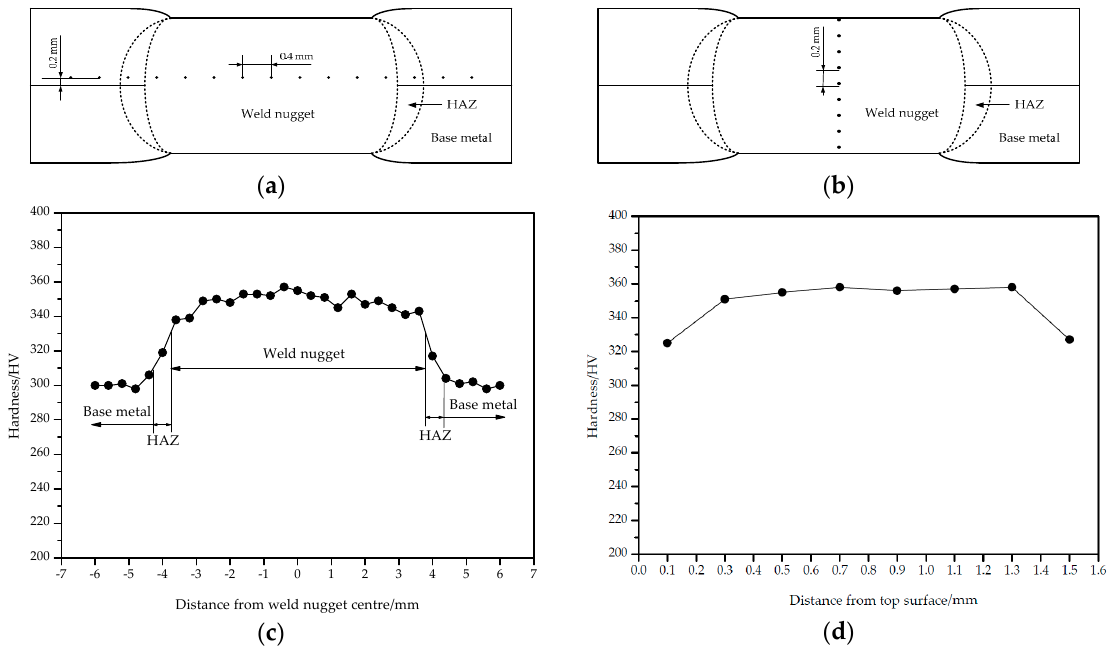
Figure 11. ( a ) Horizontal measurement location; ( b ) vertical measurement location; ( c ) horizontal hardness distribution; and ( d ) vertical hardness distribution.